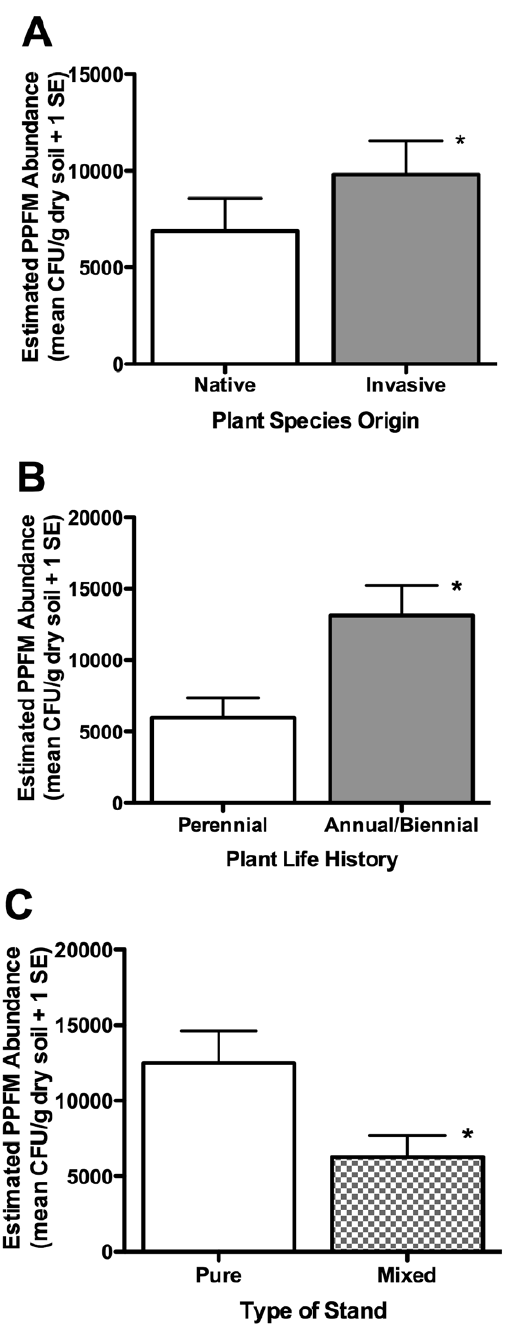
Figure 2. Average PPFM abundance in the root zone by species origin, life history, and pure and mixed stands. (a) Native versus invasive species: one-way ANOVA, (mixed and pure stands pooled) F 1,80 =5.21, P=0.0251, N=82; (b) Annual/biennial versus perennial life history: one-way ANOVA, (mixed and pure stands pooled) F 1,80 =20.45, P , 0.0001, N=82; (c) Pure versus mixed stands: two-way ANOVA, F 1,9 =4.06, P=0.048, N=82. Error bars were constructed with one standard error of the mean.